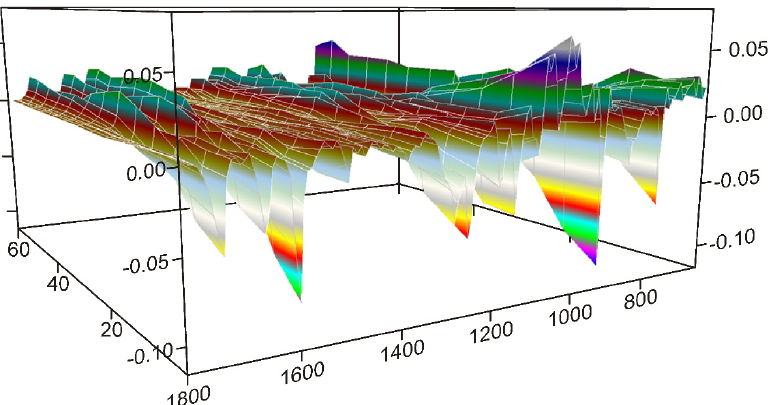
Figure 3. The dynamic surface (the different colors of the surface produced by the 3D representation belong to the values of the Y -axis), constructed from the truncated and normalized spectra between 1800 and 630 cm − 1 , and recorded between 0 and 60 min of grinding time interval, shows that the intensities of peaks change variously: increasing or decreasing or showing maximum by time. Dividing the surface into three 20-min long periods separated these intensity variations, and it gave the possibility to reveal the main processes occurring during the different stages of grind- ing.